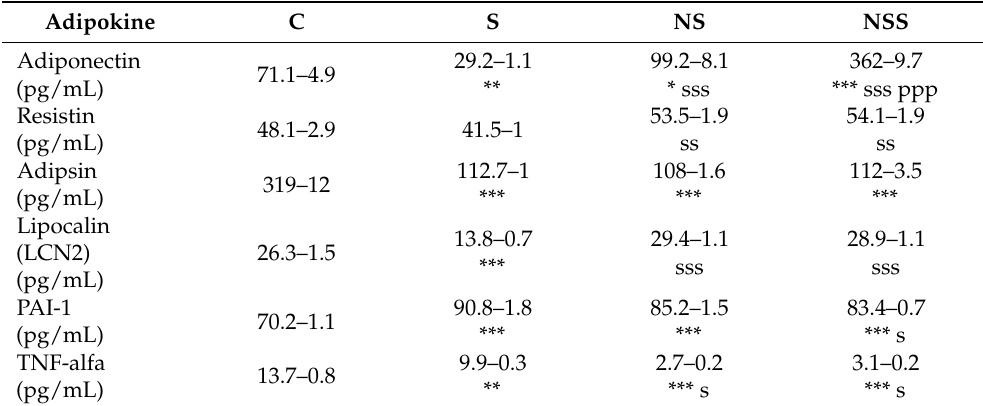
Table 2. Adipokines, hormones secreted by WAT against different stimuli, most of them metabolic and